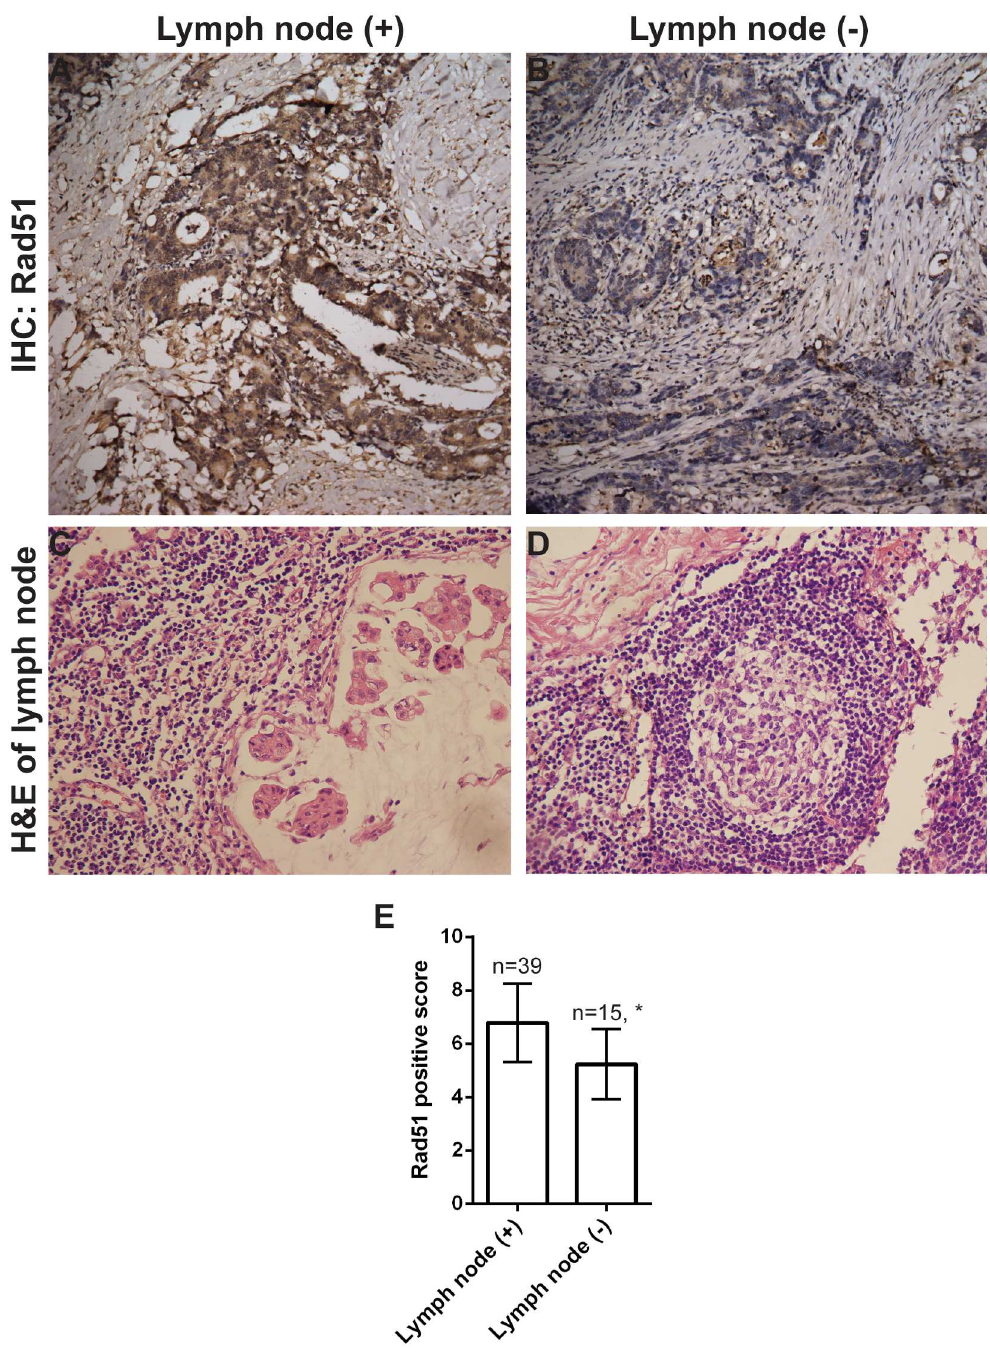
Fig 3. Rad51 expression is associated with lymph node metastasis. Strong Rad51immunoreactivity was detected in a tumor with lymph node metastasis ( A ), but not in a tumor with negative lymph node metastasis ( B ). Corresponding H&E stainingof a metastatic lymph node( C ) and a negativelymph node ( D ). Representative images with originalmagnification at 200X. (E) Quantitation of Rad51expressionin patients with lymph node metastasis versus patients without. * p = 0.002.